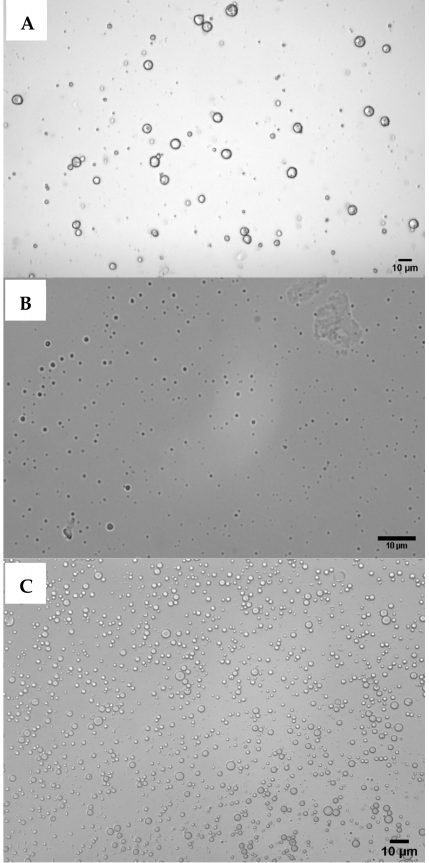
Figure 2. Light microscopy (40 × ) images of carnauba wax ( A ), κ -carrageenan ( B ), and PLGA ( C ) microspheres produced by adapting melt dispersion [17], emulsion [18], and water-in-oil-in-water double emulsion solvent evaporation [19] techniques,